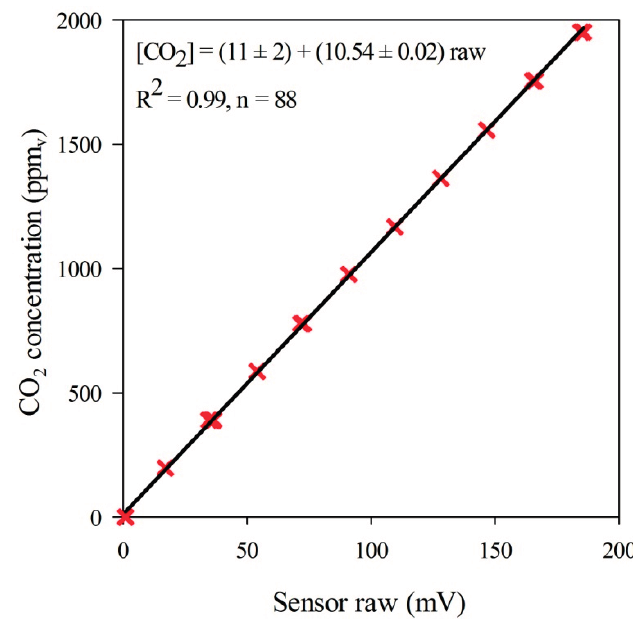
Figure 6. Plot of the linear response of sensor (mV) to calibration gas CO 2 concentration (ppm v